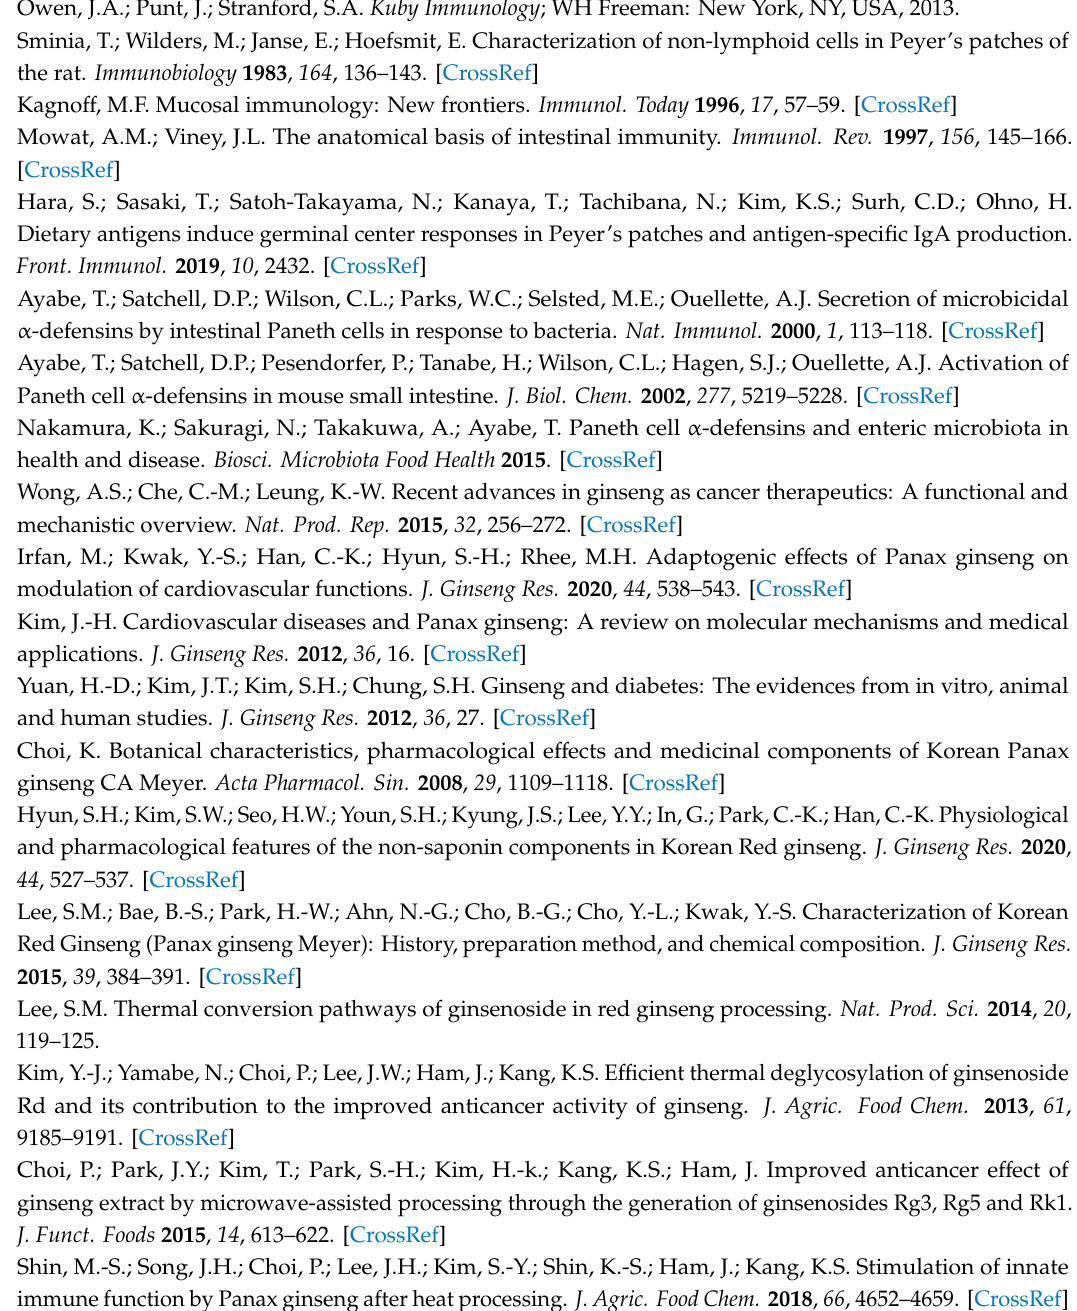
Figure S1: A HPLC chromatograms KRG-P monosaccharide